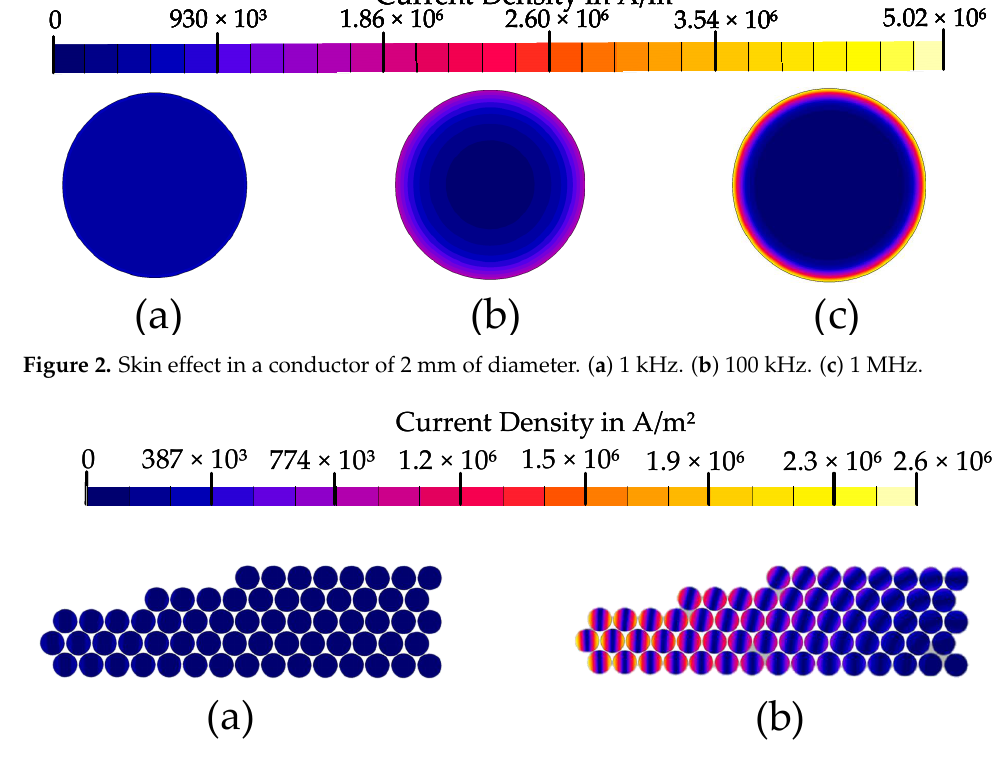
Figure 3. Proximity effect in a middle slot of a machine. ( a ) 1 kHz ( b ) 10